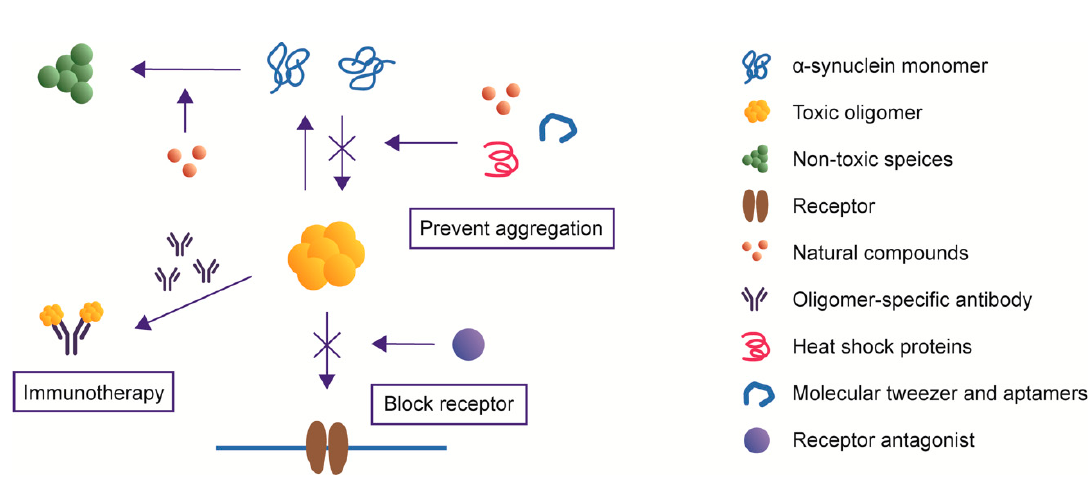
Figure 4. Therapies targeting α -syn oligomers. Natural compounds, heat shock proteins and molecular tweezers reduce the level of toxic oligomers. Oligomer-specific antibodies neutralize certain kinds of α -syn oligomers. Receptor antagonist prevents the oligomers from binding to the receptors and exhibiting cytotoxicity.